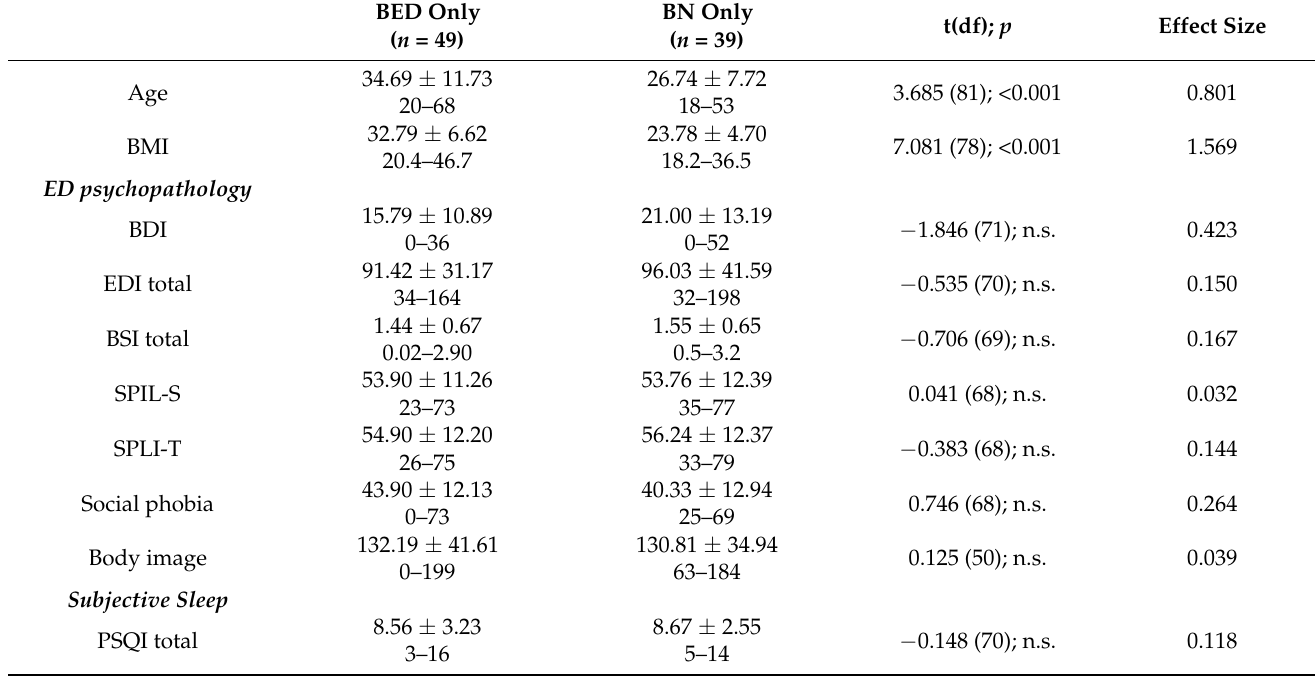
Table 1. Comparison of BN and BED in terms of objective and subjective quality of sleep and ED-related psychopathologies (mean ± sd;